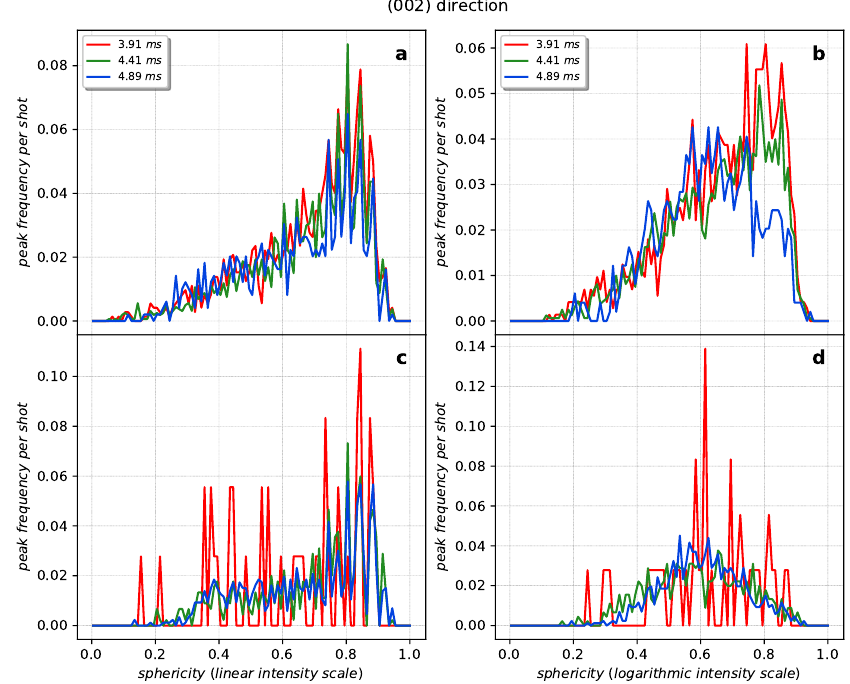
Figure A4. Frequency of a peak appearing with a certain sphericity for the (002) direction for the hits above 50 ADU/pixel ( a ) in linear and ( b ) in logarithmic intensity scales as well as the hits below 50 ADU/pixel ( c ) in linear and ( d ) in logarithmic intensity